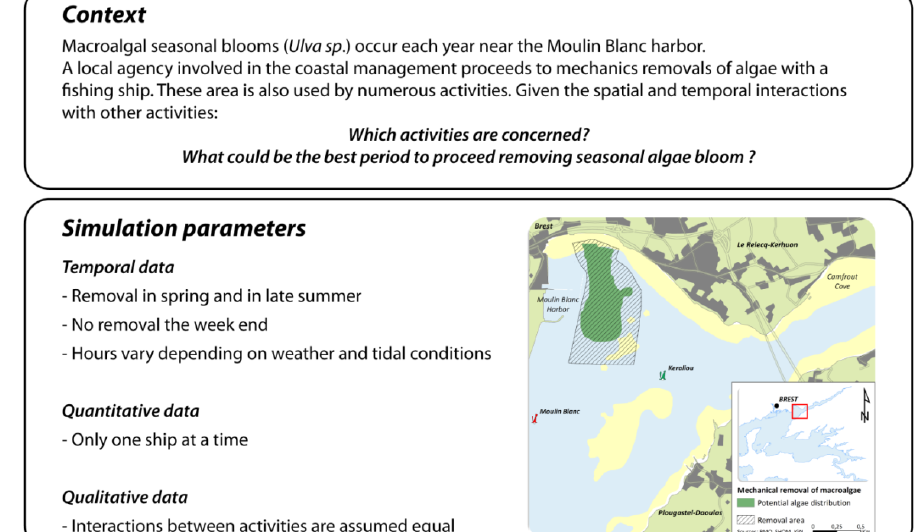
Figure 8. An example of scenario: removal of macro-algal